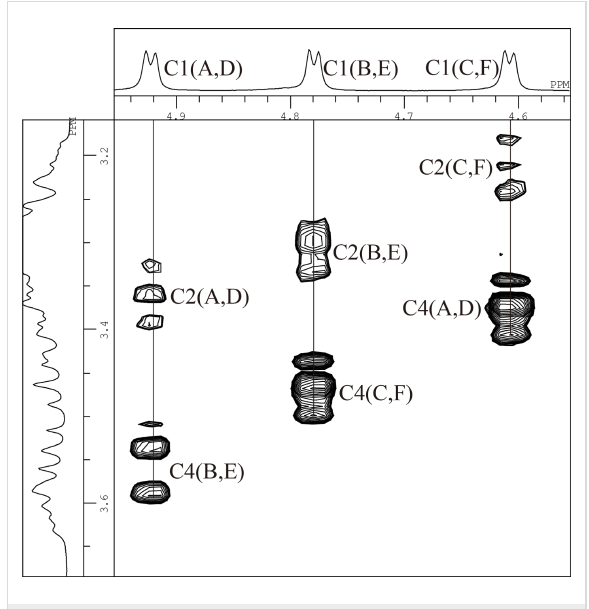
Figure 11: A part of 2D ROESY spectrum of the A,D-isomer in DMSO- d 6 at 50 °C.